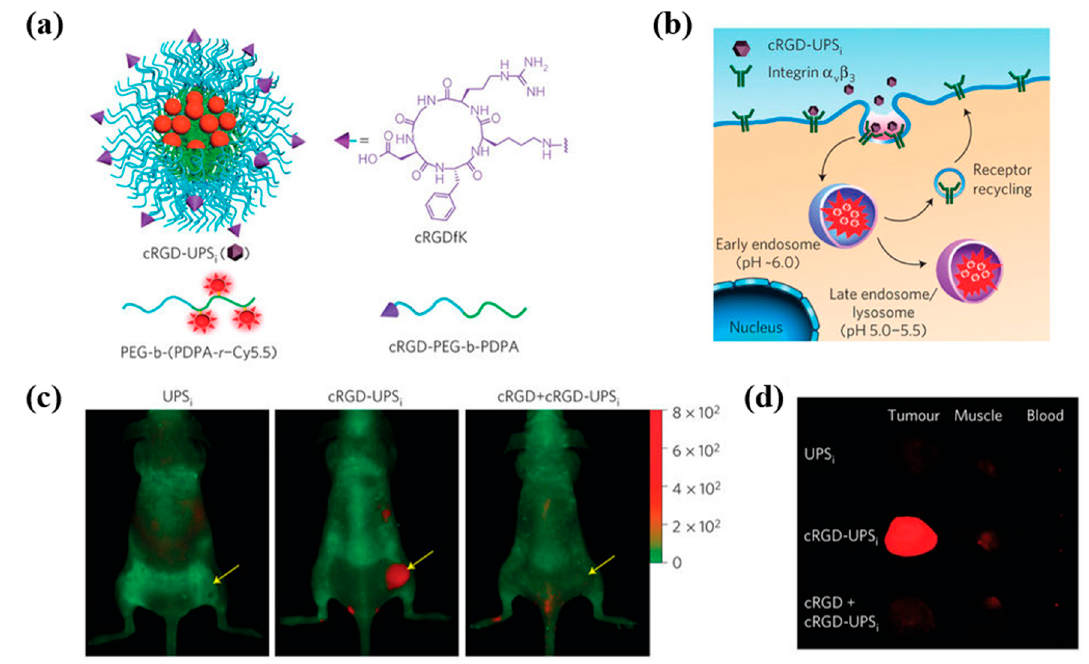
Figure 4. ( a ) Design of the cRGD-UPS i nanoprobe. ( b ) Schematic illustration of α v β 3 -mediated endocytosis of the cRGD-UPS i nanoprobe in tumor endothelial cells. ( c ) Superimposed fluorescent images of A549-tumor-bearing mice at 6h postinjection of cRGD-UPS i or the UPS i nanoprobe. In the competition group, a blocking dose of cRGD peptide was injected 30min before cRGD-UPS i administration. Cy 5.5 (red) and autofluorescence (green) are separately shown in the composite images and ( d ) representative images of ex vivo tumors, muscles, and blood at 6h post-injection of nanoprobes. Reprinted with permission from Reference [81]. Copyright 2014 Springer